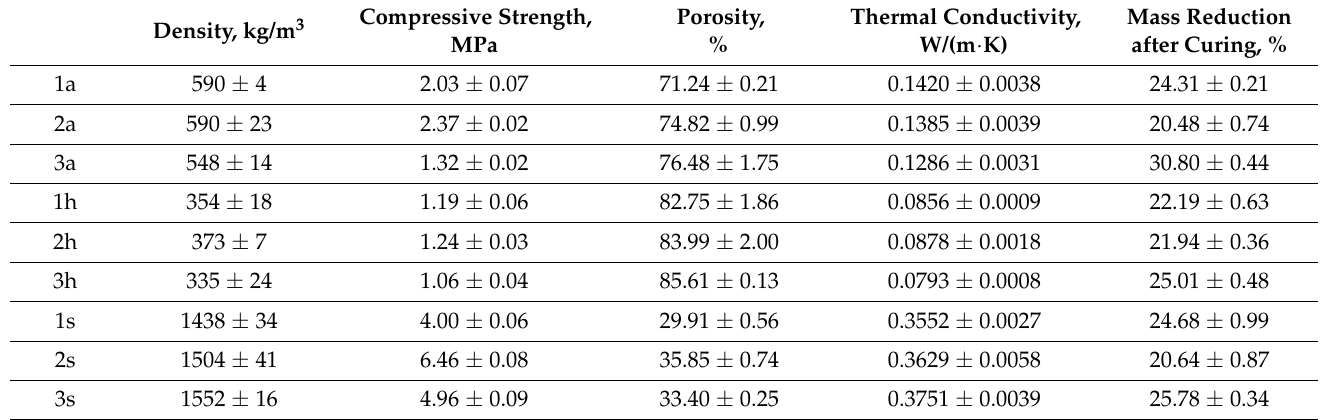
Table 4. Medium characteristics of the synthesized samples.